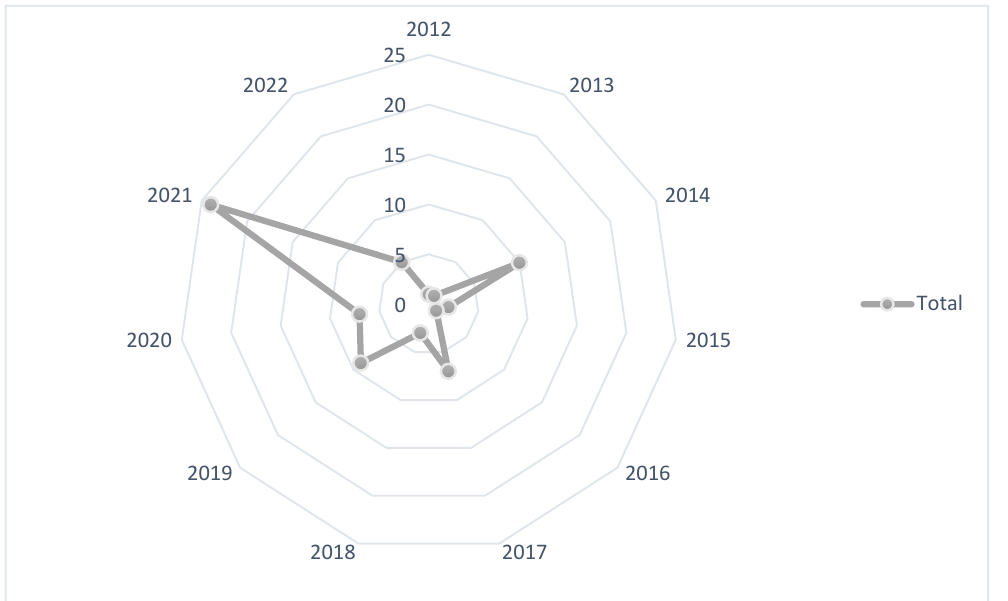
Figure 3. Count of articles against publication year.